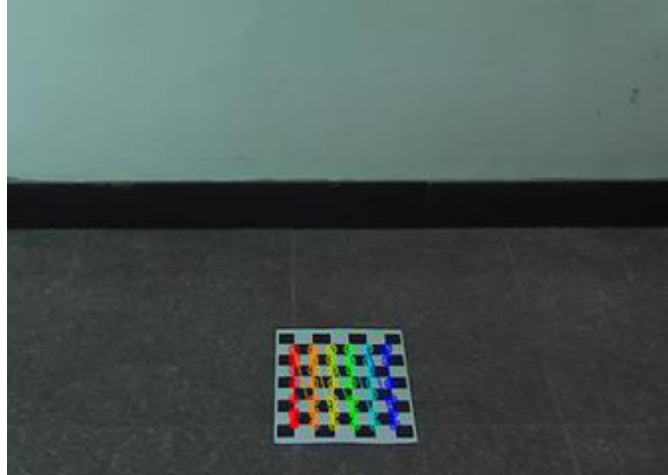
Table 6. Camera extrinsic parameter information by solvePnP.